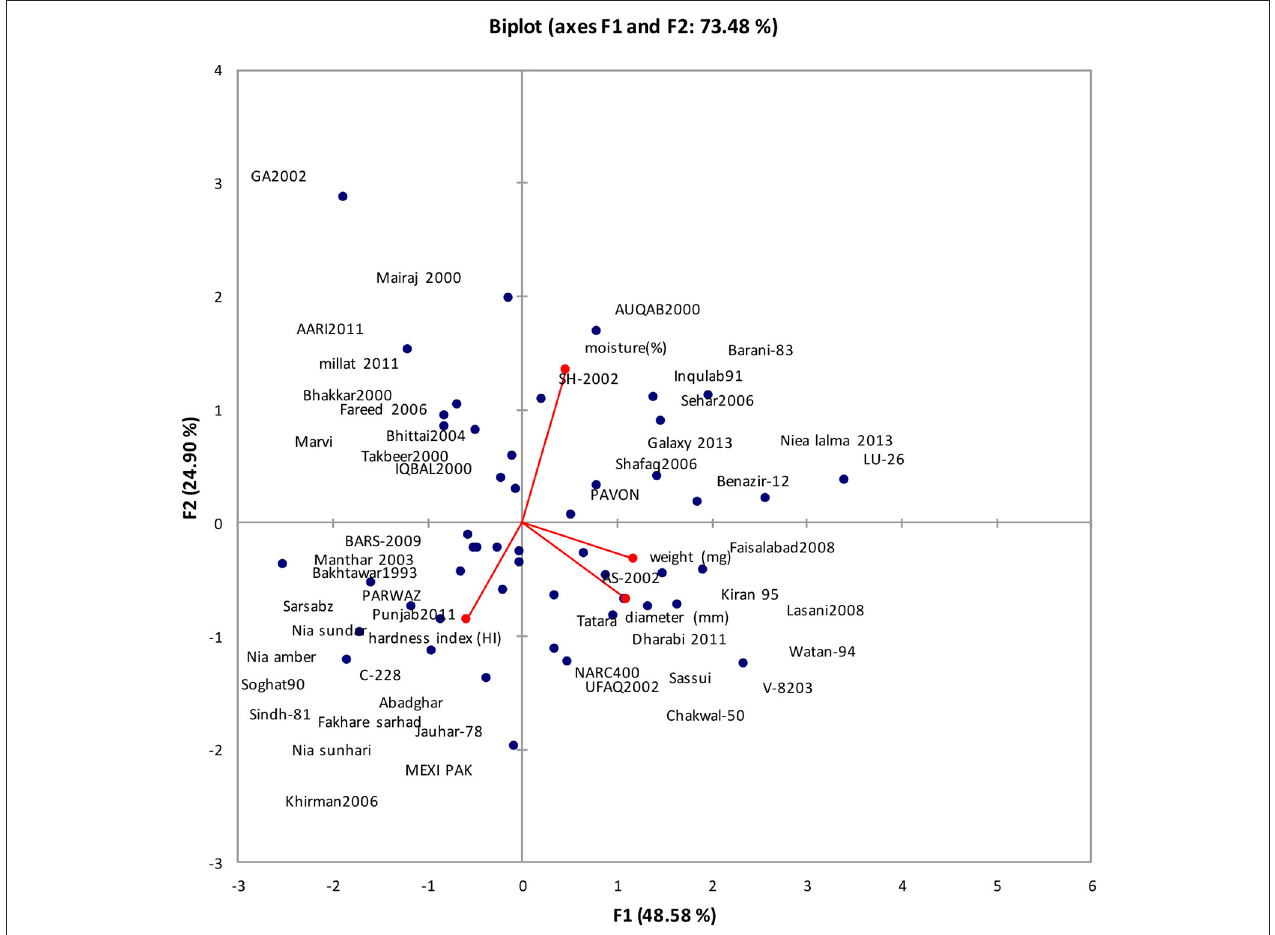
FIGURE 3 | Bi-plot of wheat genotypes for first two principal components regarding single kernel characterization system.